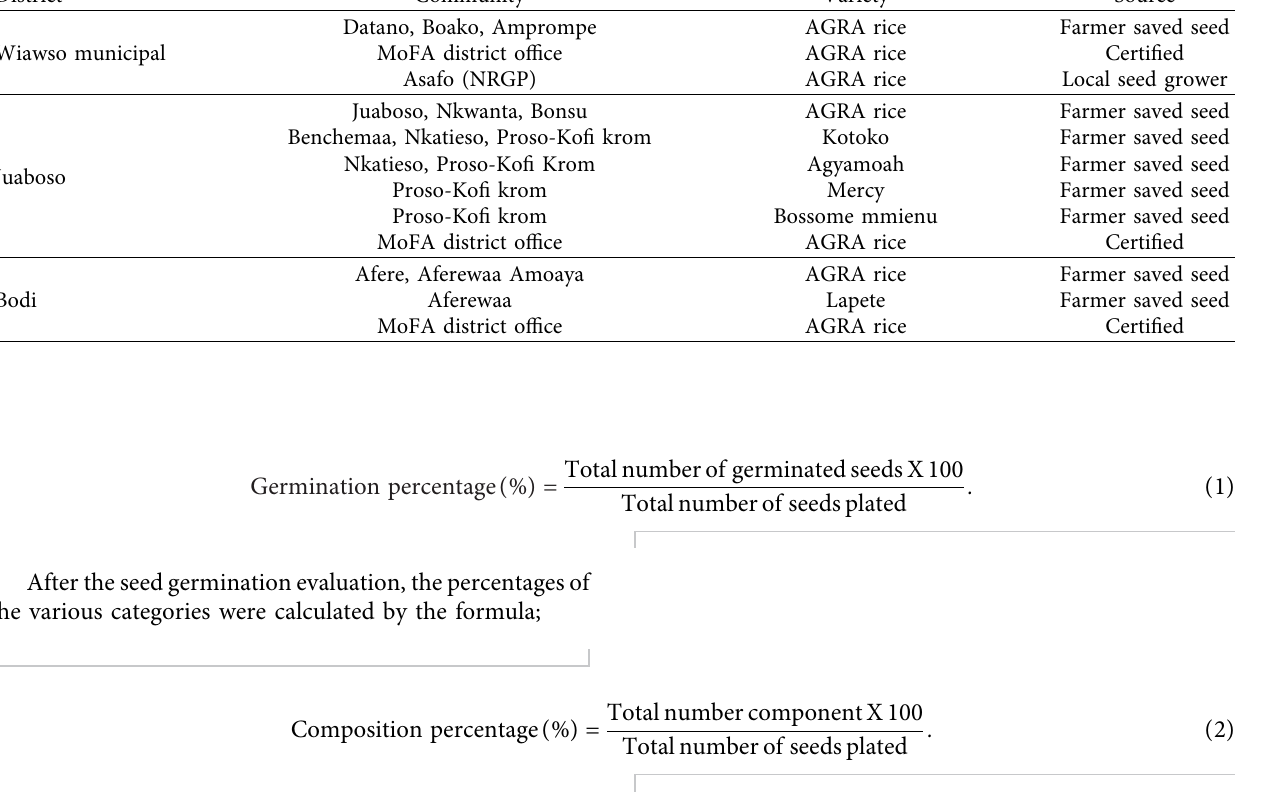
Table 1: Sources and varieties of seed samples obtained from the three selected districts.